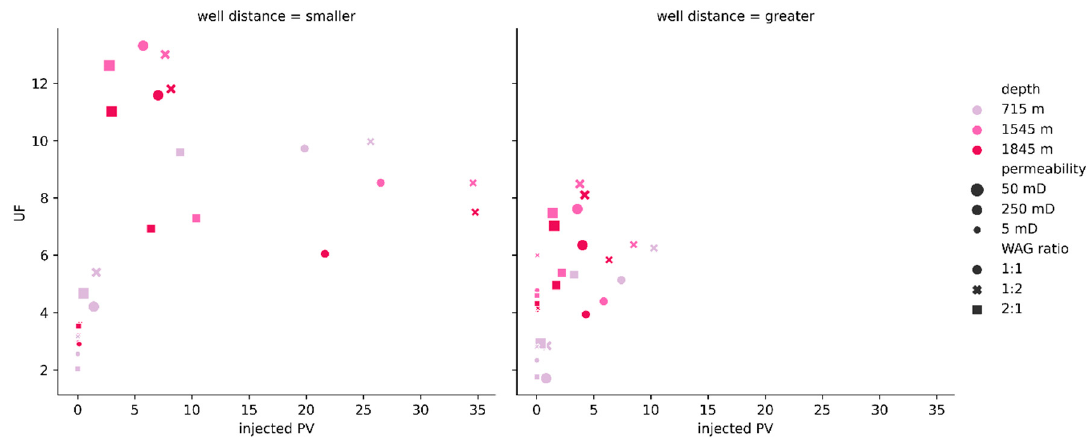
Figure 11. Utilization factor (UF) versus injected PV after 15 years of EOR.